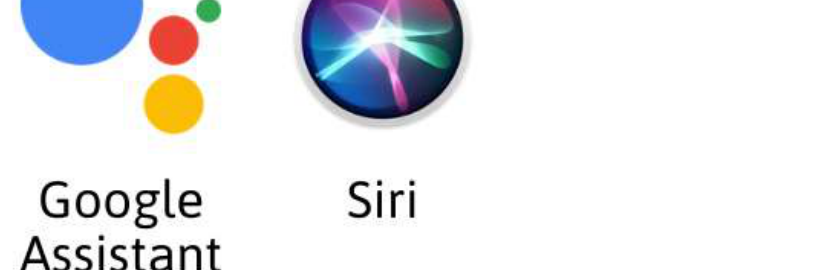
Figure 11. Differences between required devices and actions during an inaudible attack on voice assistants.